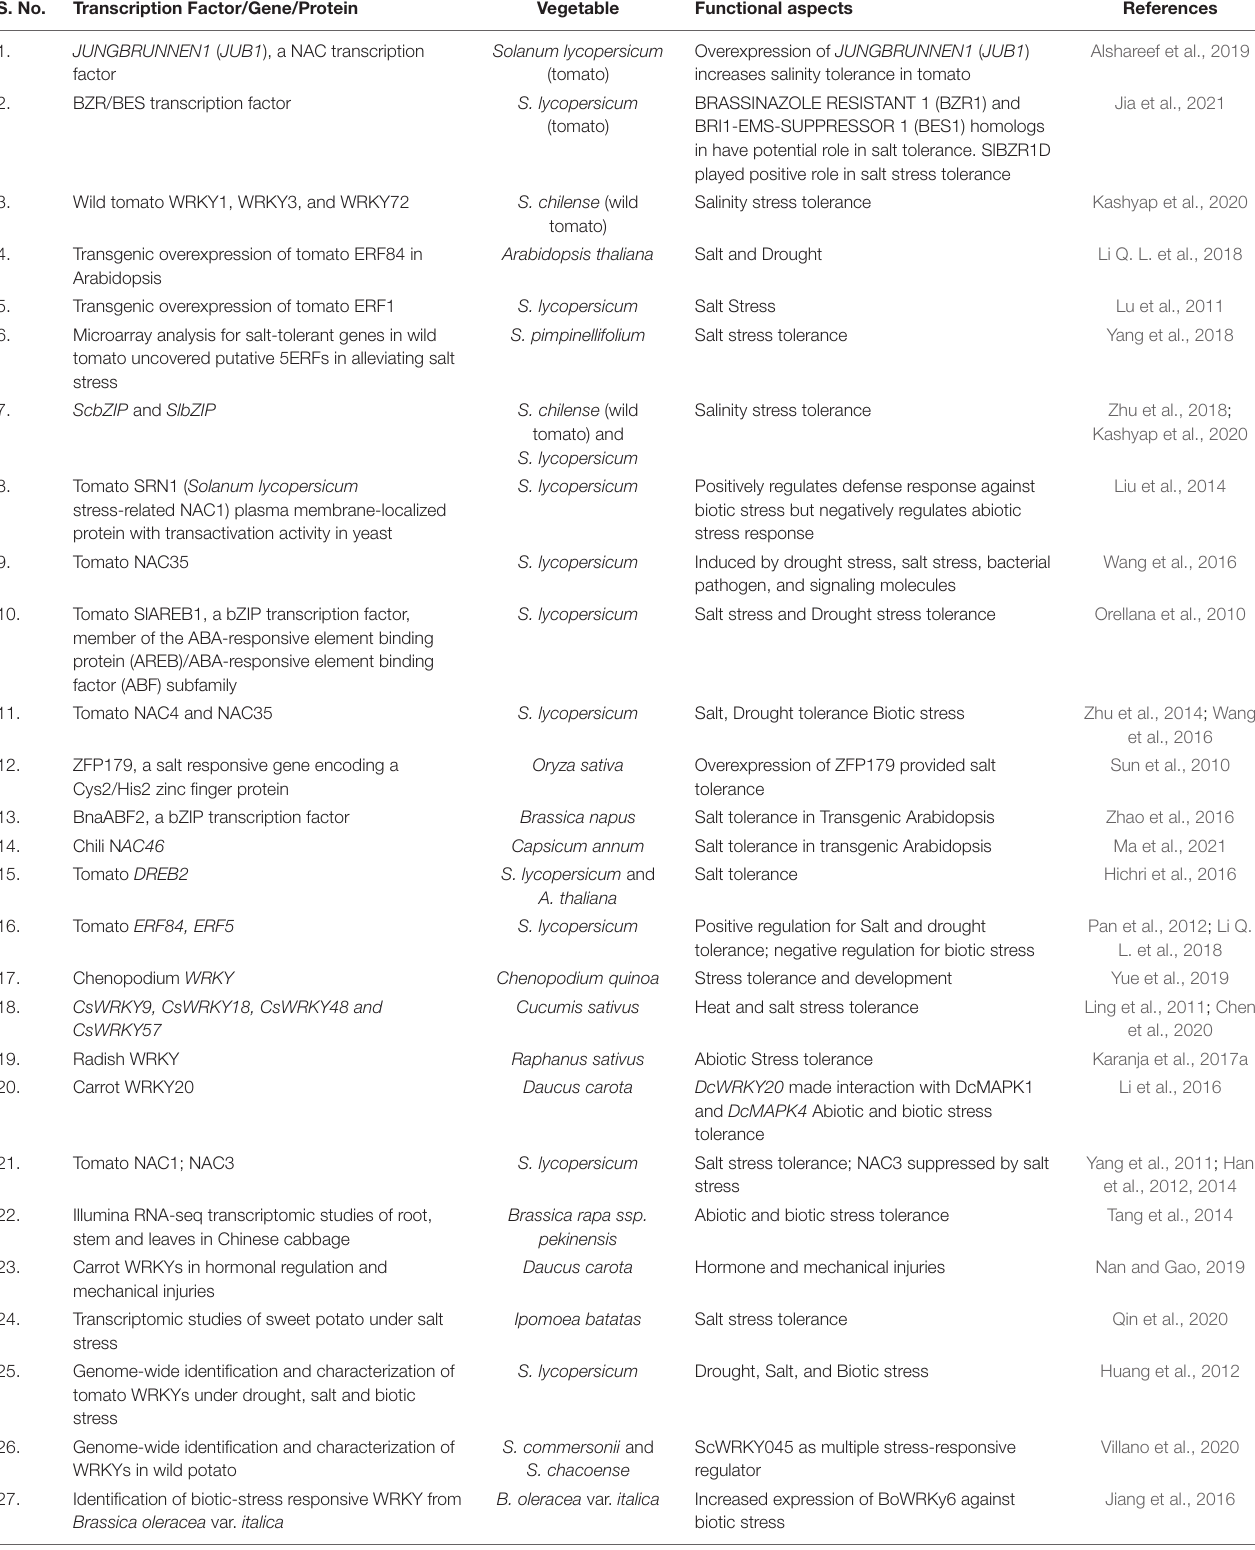
TABLE 4 | Transcriptional regulation and their mode of action in vegetable crops for salt stress tolerance. S.